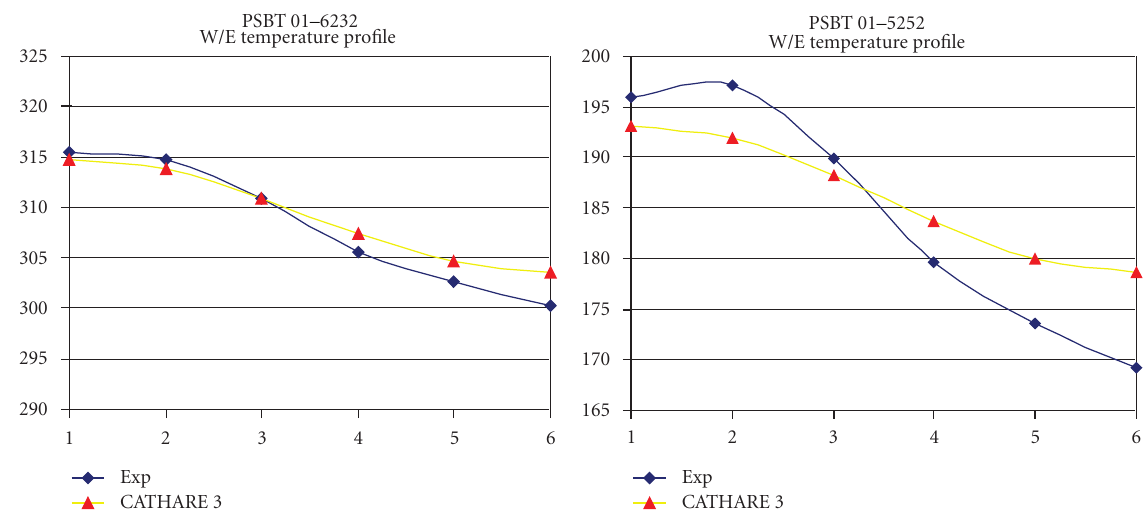
Figure 12: Temperature profiles in 2 fluid temperature measurement